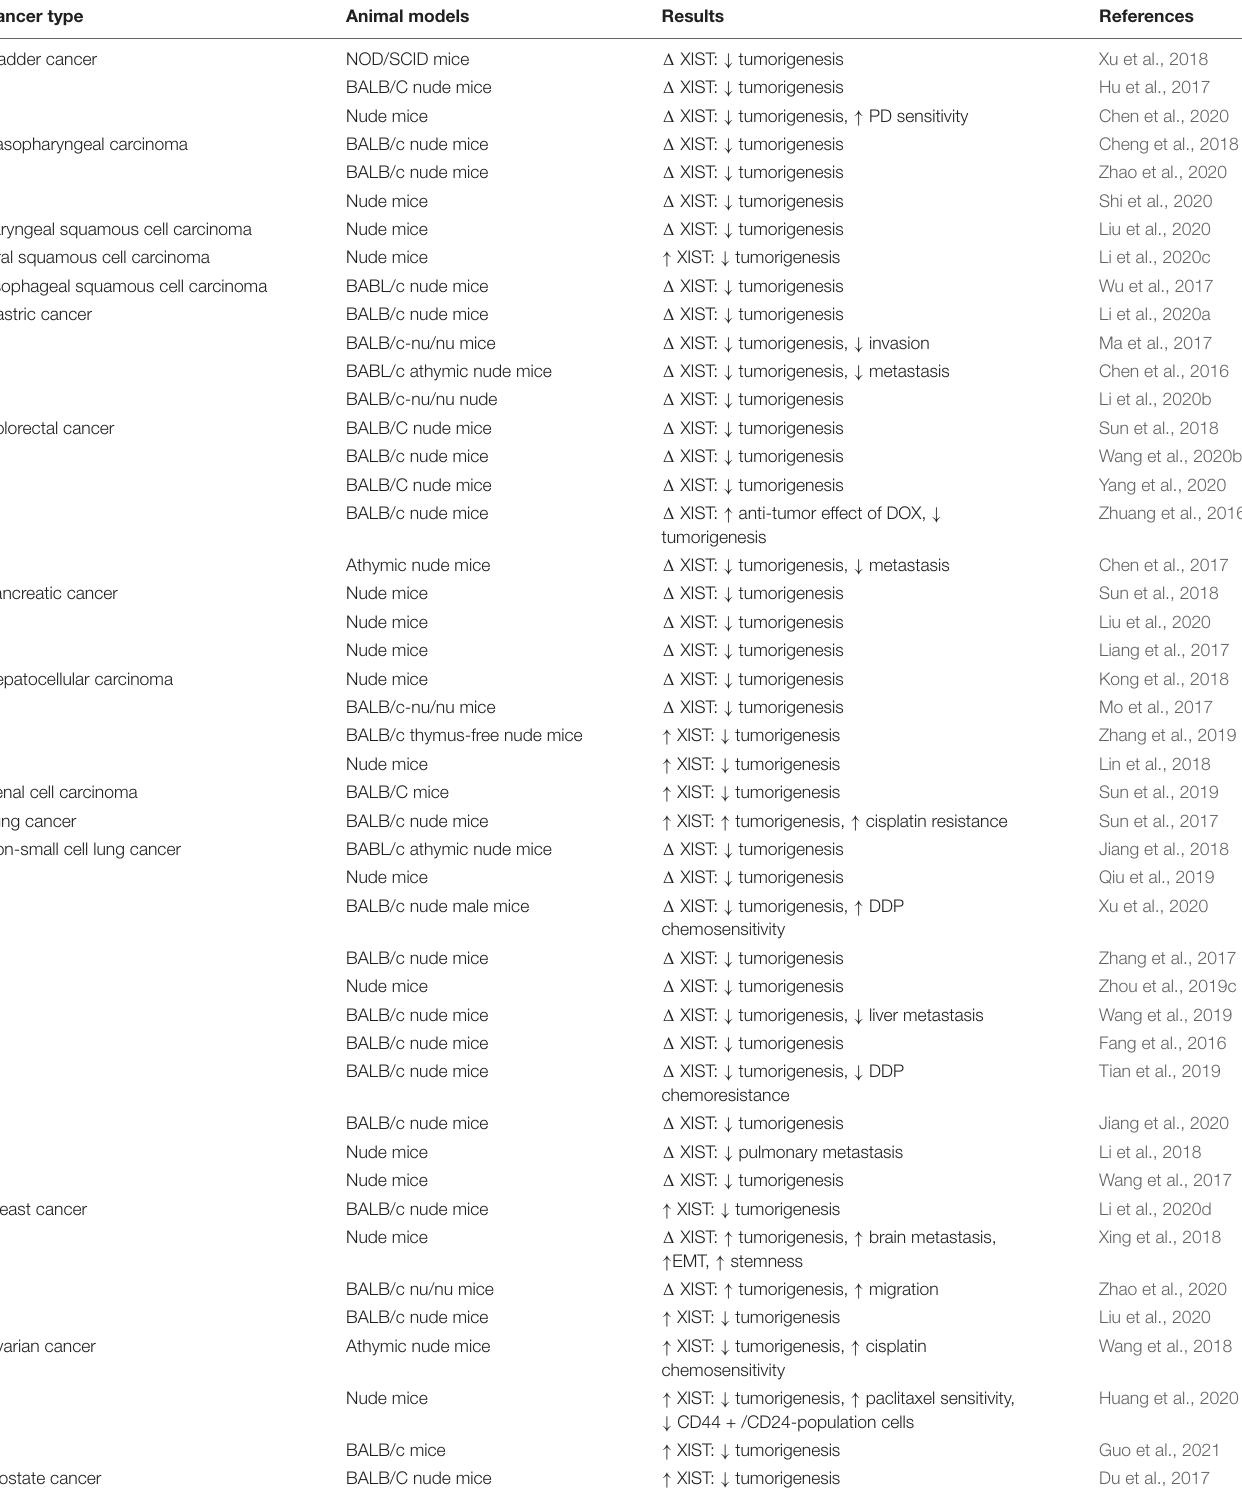
TABLE 1 | Outcomes of studies which evaluated function of XIST in animal models ( (cid:49) : knock down or deletion). Cancer